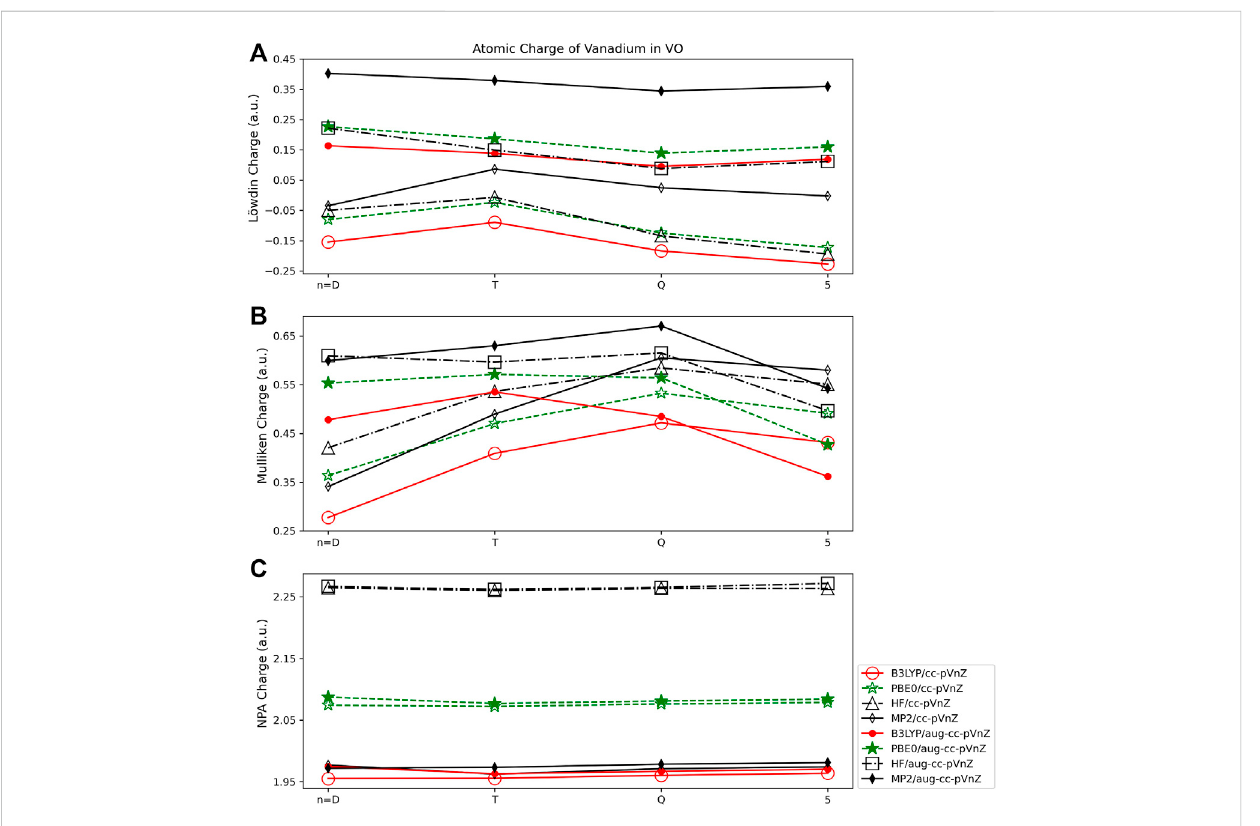
FIGURE 7 Atomic charge of vanadium in VO determined using a number of different theoretical methods, Dunning style basis sets, and wavefunction-based population analysis methods: (A) Löwdin, (B) Mulliken, and (C) NPA (*Note that scales vary from one analysis method to another.).